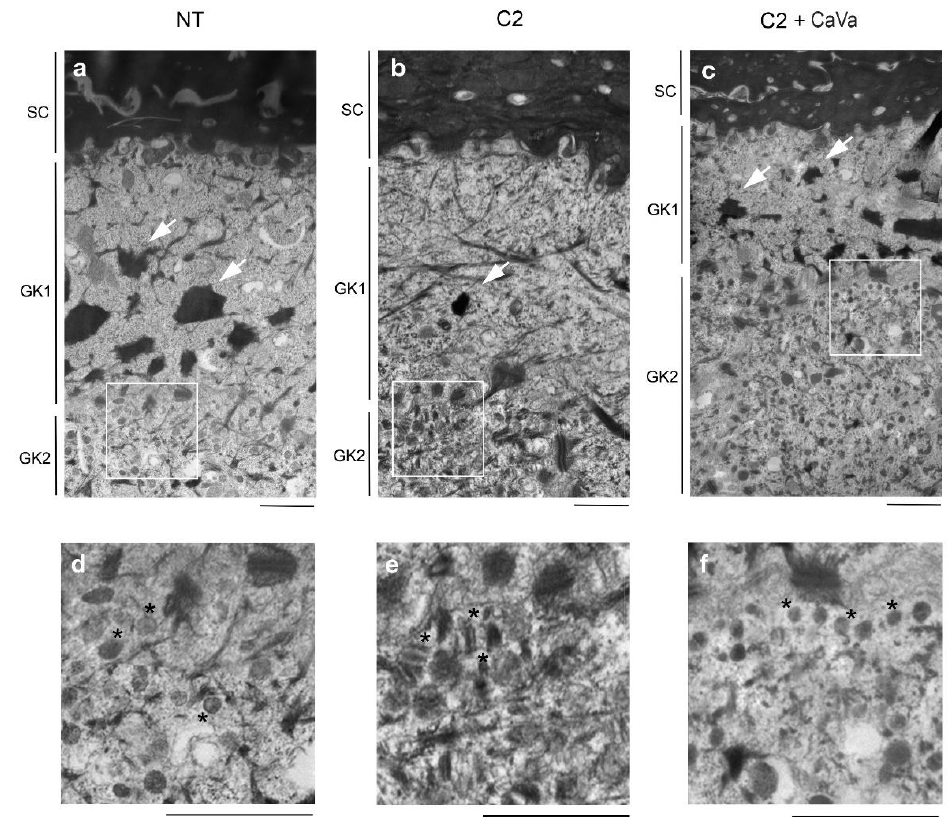
Figure 3. Ultrastructural analysis of reconstructed human epidermis (RHE). Non-treated (NT) RHEs ( a ) and RHEs treated with either the cocktail of cytokines at 20 ng/mL (C2) ( b ) or the cocktail and the extract of Castanea sativa (C2 + CaVa) ( c ) were analyzed using transmission electron microscopy. Scale bar = 1 µm. SC, stratum corneum ; GK1, upper granular keratinocyte; GK2, second granular keratinocyte; *, lamellar bodies ( d , f ) or unidentified vesicles ( e ). Arrows show keratohyalin gran-ules.